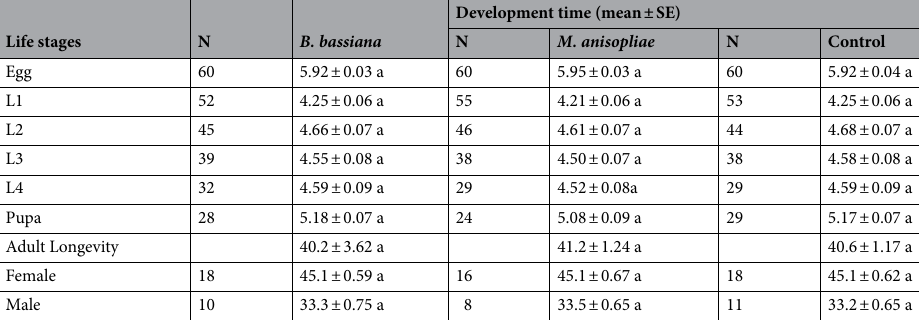
The initials size of the population was recorded 10 eggs for each treatment. The highest population size of beetle (573.43 individuals) was in the control group followed by 553.21 individuals in M. anisopliae treatment. The total population size in B. bassiana treatment was 510.46 individuals (Fig. 5).